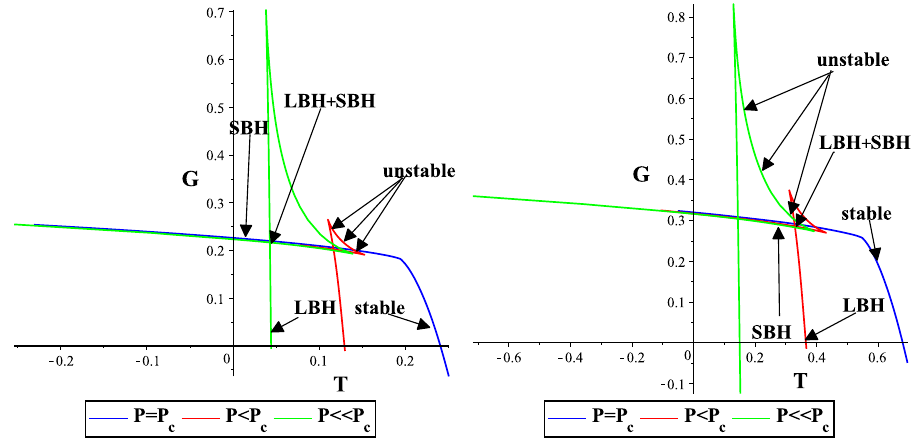
Fig. 17 Gibbs energy vs Temperature for the fixed Pressure, e = 0 . 1 and g = 0 . 2. left panel: a 2 = 1, right panel: a 2 =